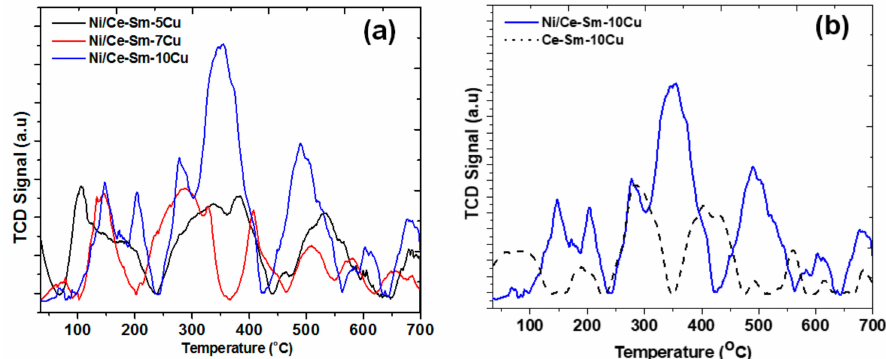
Figure 8. CO2-Temperature Programmed Desorption (CO2-TPD) profiles over the: ( a ) Ni/Ce-Sm-xCu (x = 5, 7 and 10 at.%) catalysts; ( b ) Ni/Ce-Sm-10Cu catalyst and Ce-Sm-10Cu